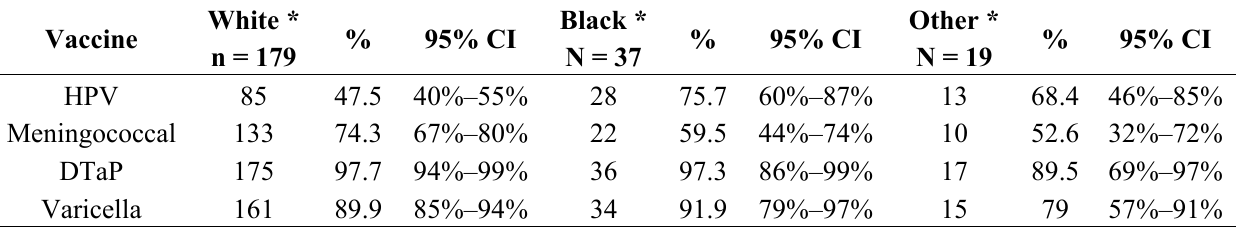
Table S2. Supplemental data for Figure 2.